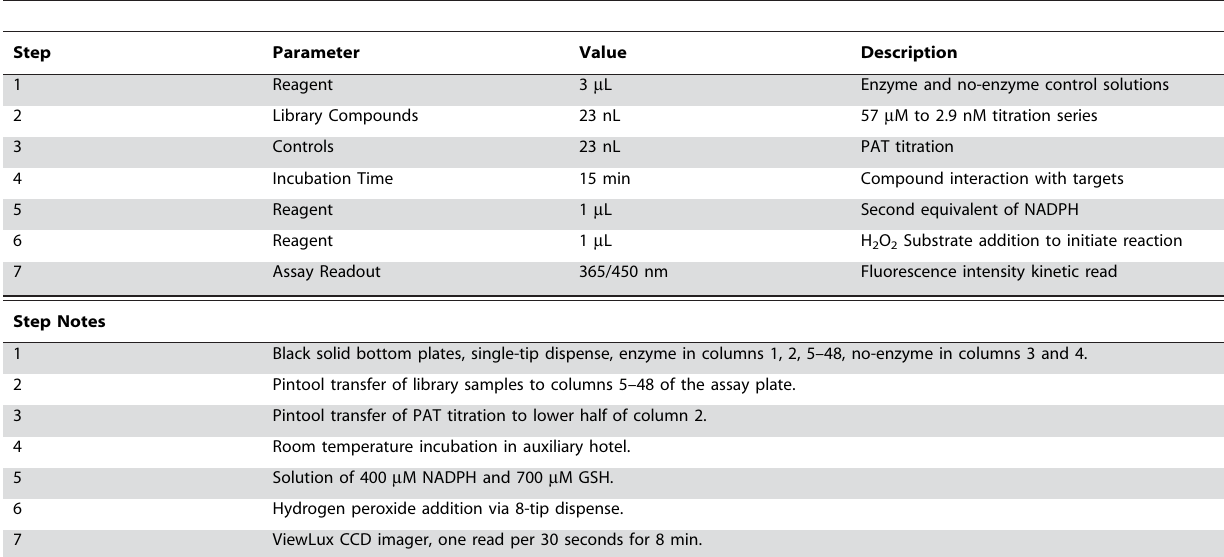
Table 1. S. mansoni redox cascade qHTS